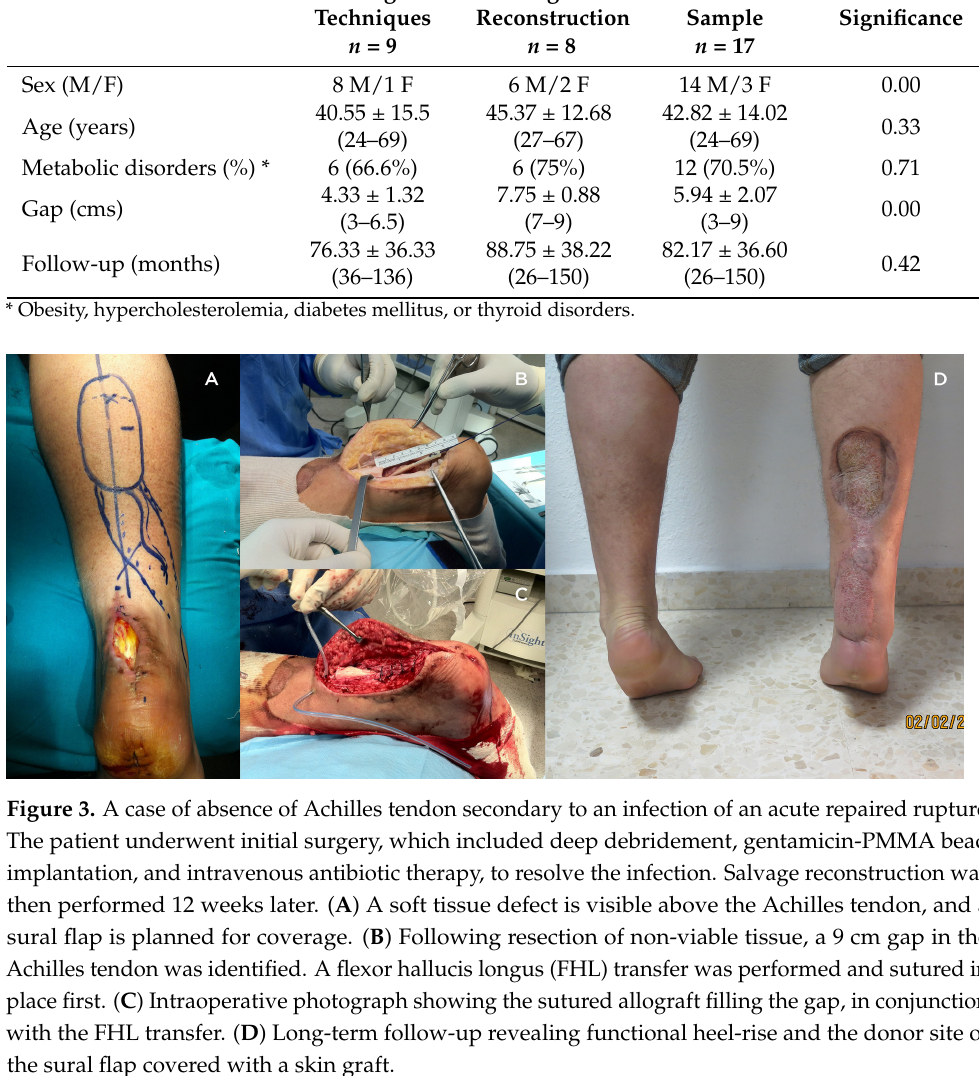
Table 2. Demographic, patient characteristics, and follow-up data in global sample and subgroups. Autologous Allograft